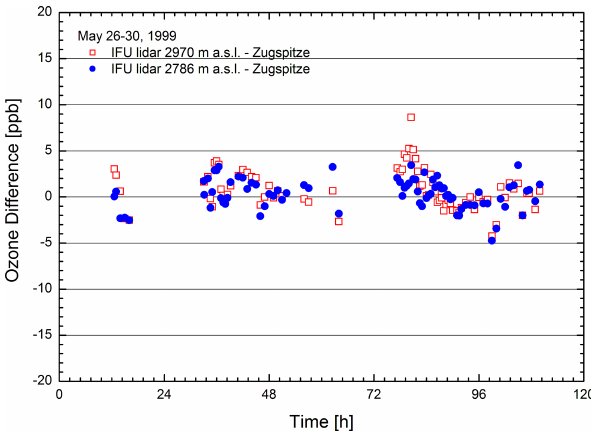
Figure 13. Comparison of the stationary DIAL with the Zugspitze in situ data during 4d in May 1999 (VOTALP Munich field cam- paign); the deviations have since diminished to about one-half of the noise shown